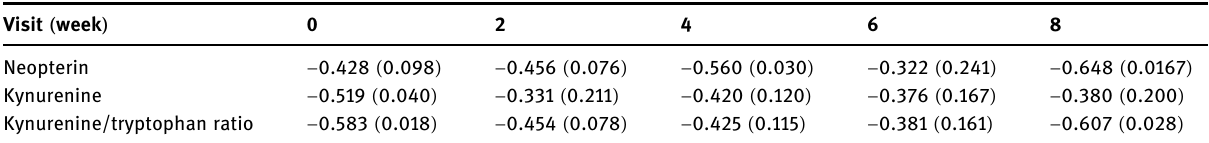
Table 5: Correlation ( Spearman ’ s rank correlation coe ffi cient ) between toxicity grade and serum neopterin and kynurenine concentrations, and kynurenine/tryptophan ratio before and during the course of the treatment Visit ( week )